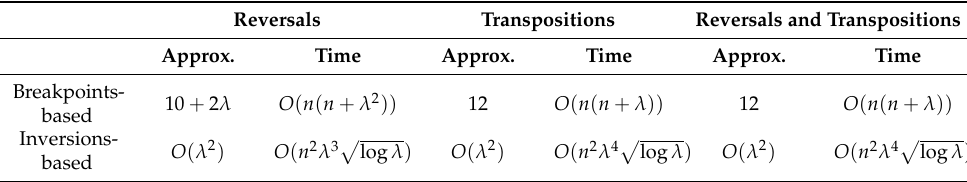
Table 2. Summary of the approximation results for the problems considering unsigned permutations. The columns “Approx.” and “Time” refer to the theoretical approximation factor and the worst-case complexity time, respectively. Reversals Transpositions Reversals and Transpositions Approx.